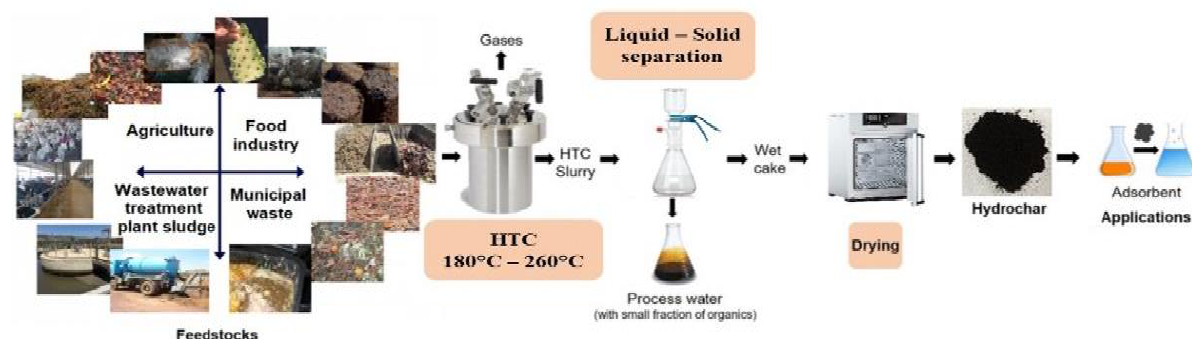
Figure 2. Illustration of the HTC process for different wastes and the generation of HC adsorbents (adapted from [31]).